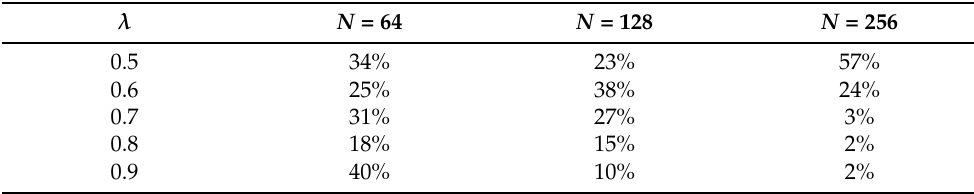
Table 3. NMI decreasing speed with noise increasing ( λ decreasing) under different N .